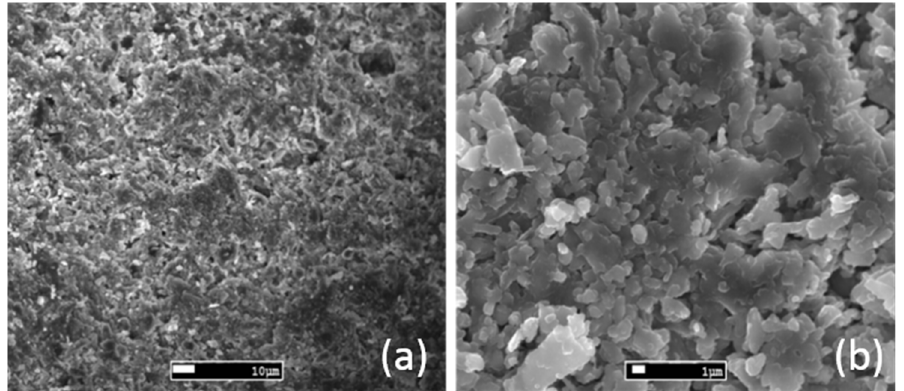
Figure 1. SEM micrograph of the coated concrete specimen at the interface region: magnification ( a ) ×60, ( b ) ×200.